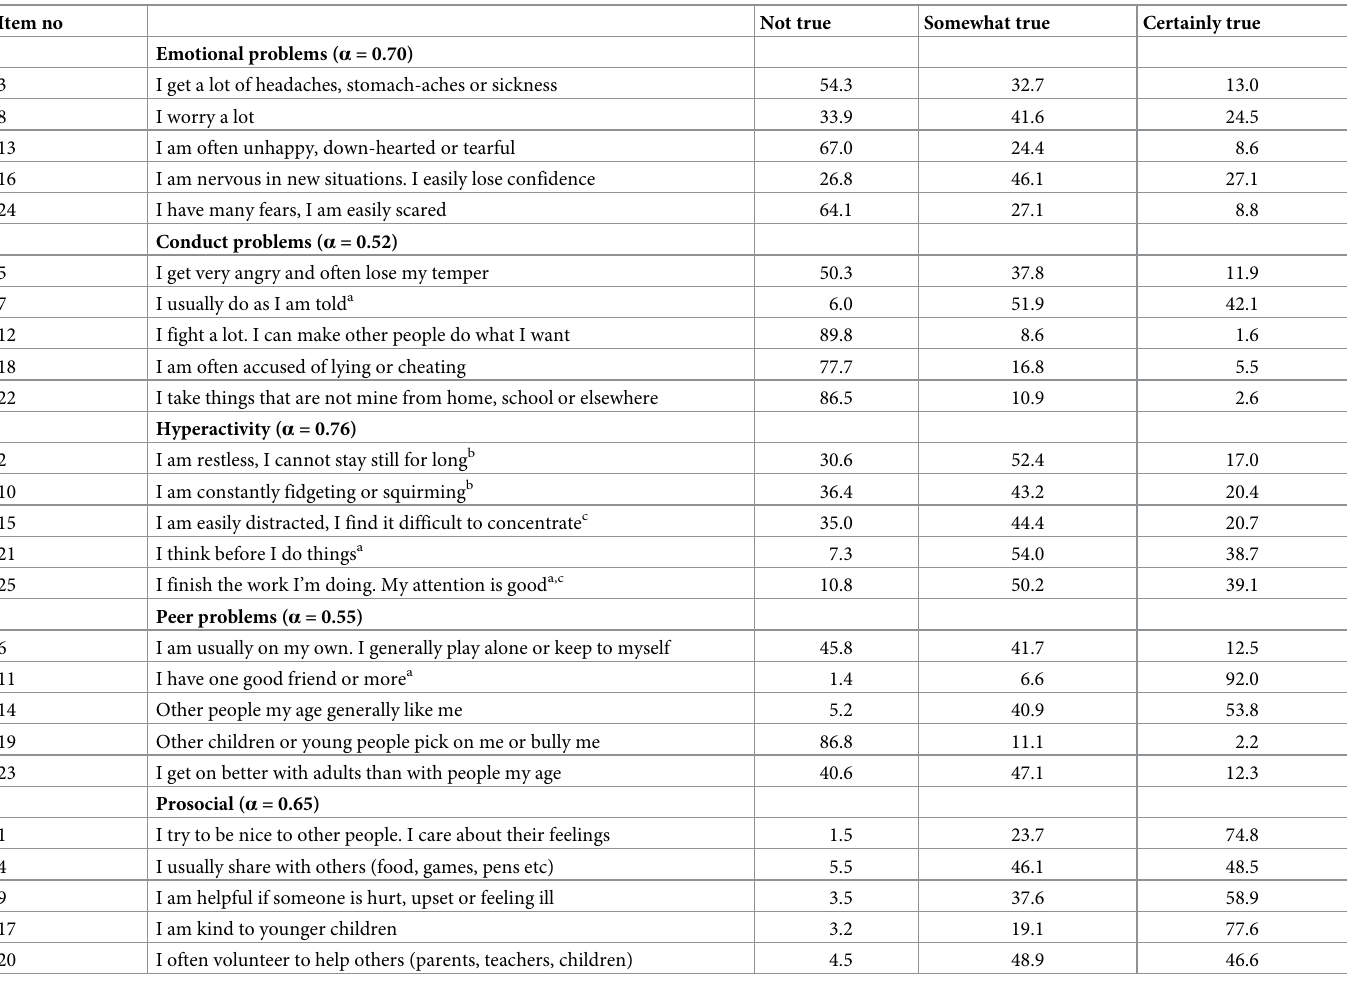
Table 1. Item responses for Strength and Difficulties Questionnaire (SDQ).